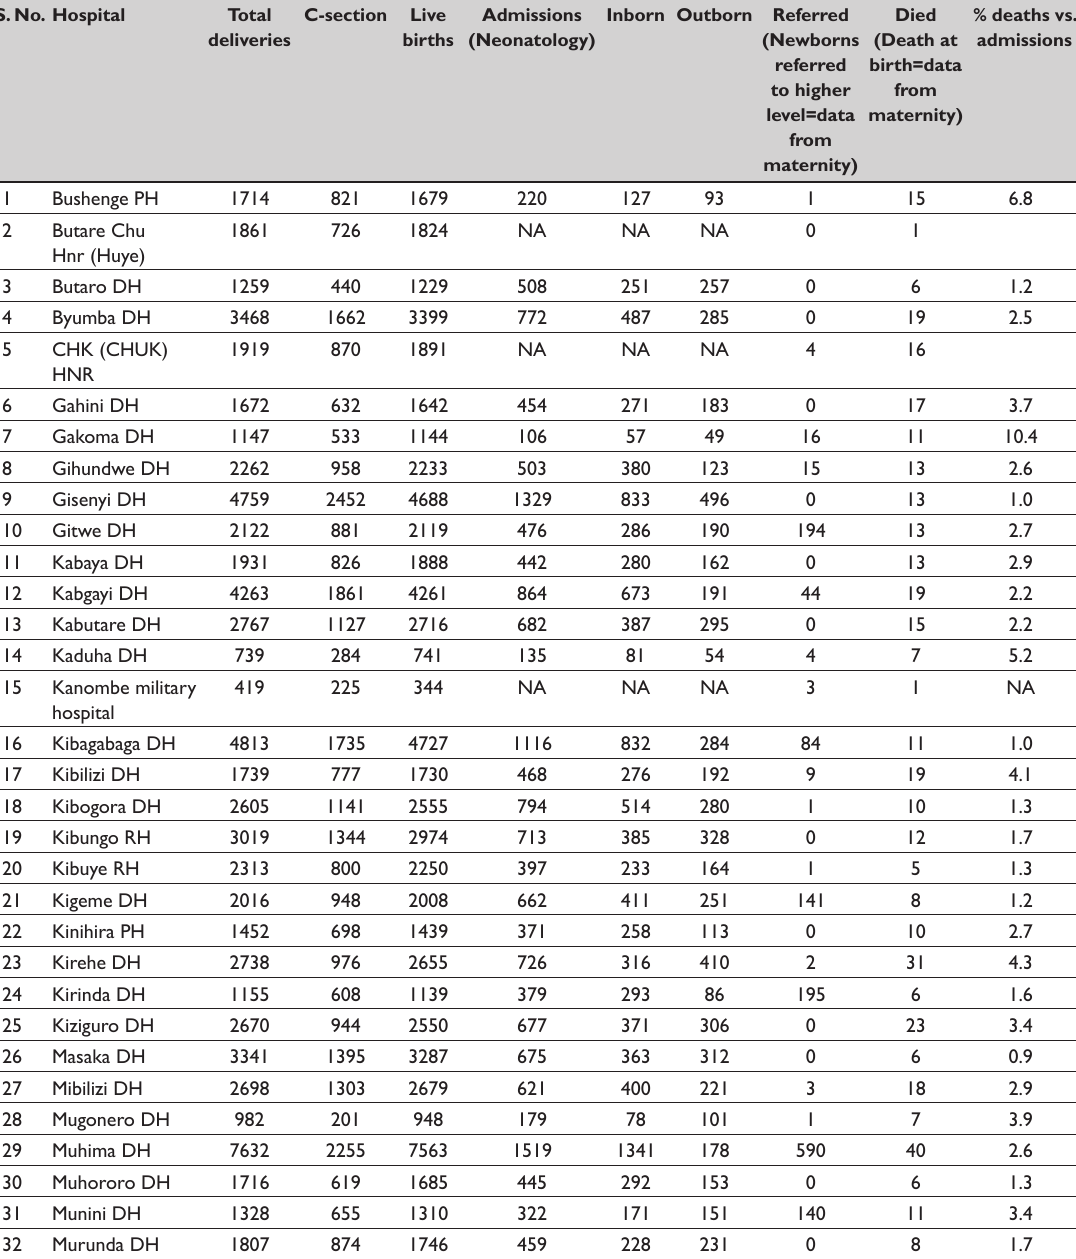
Table 8: Health management information system analysis from Jan 1, 2015 to Dec 31, 2015 (TG: include this table in